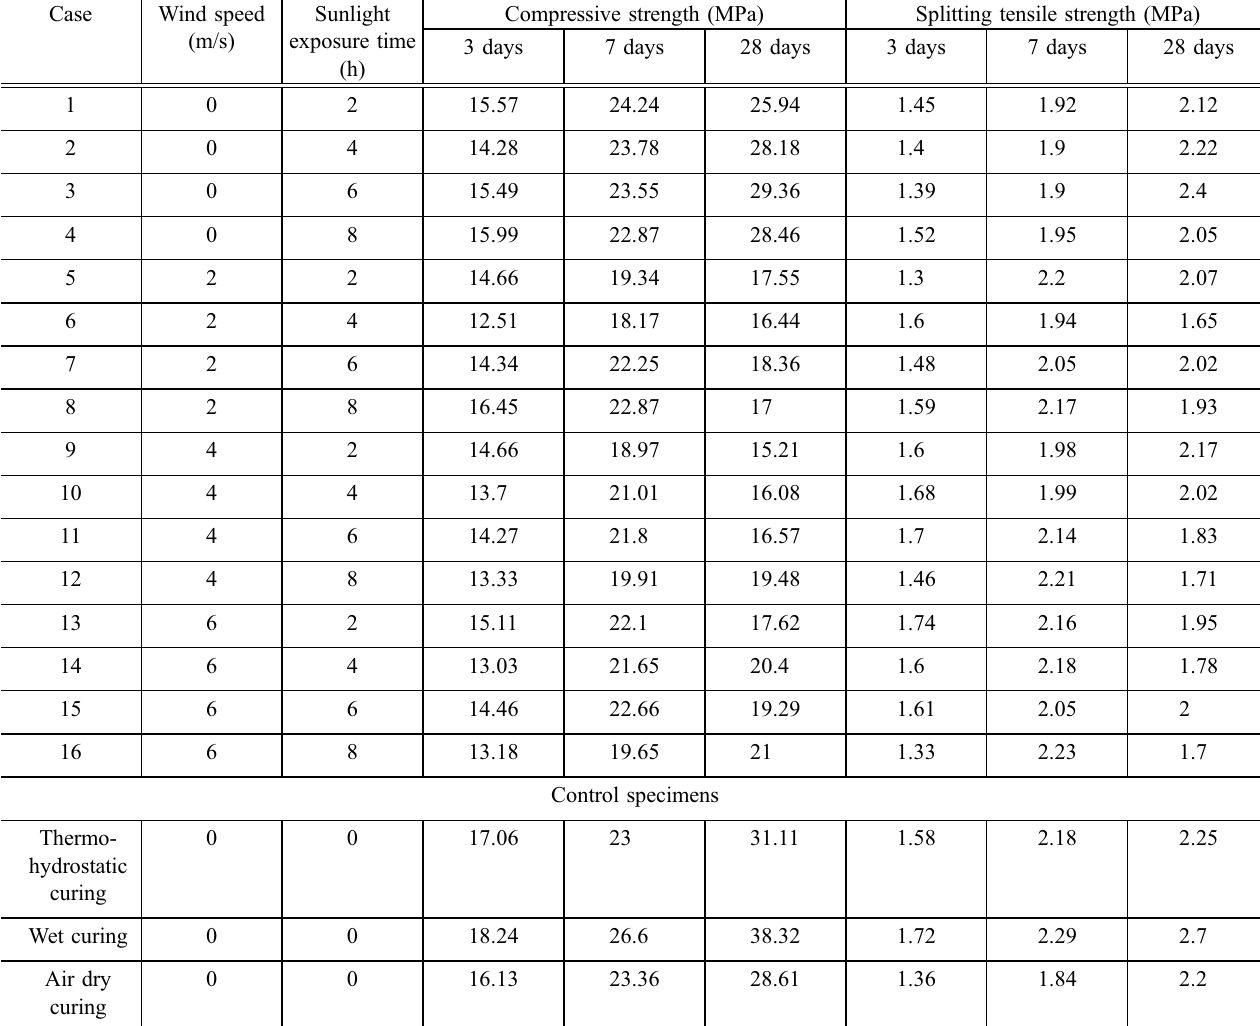
Table 5 Strength test results of wind speed—sunlight exposure